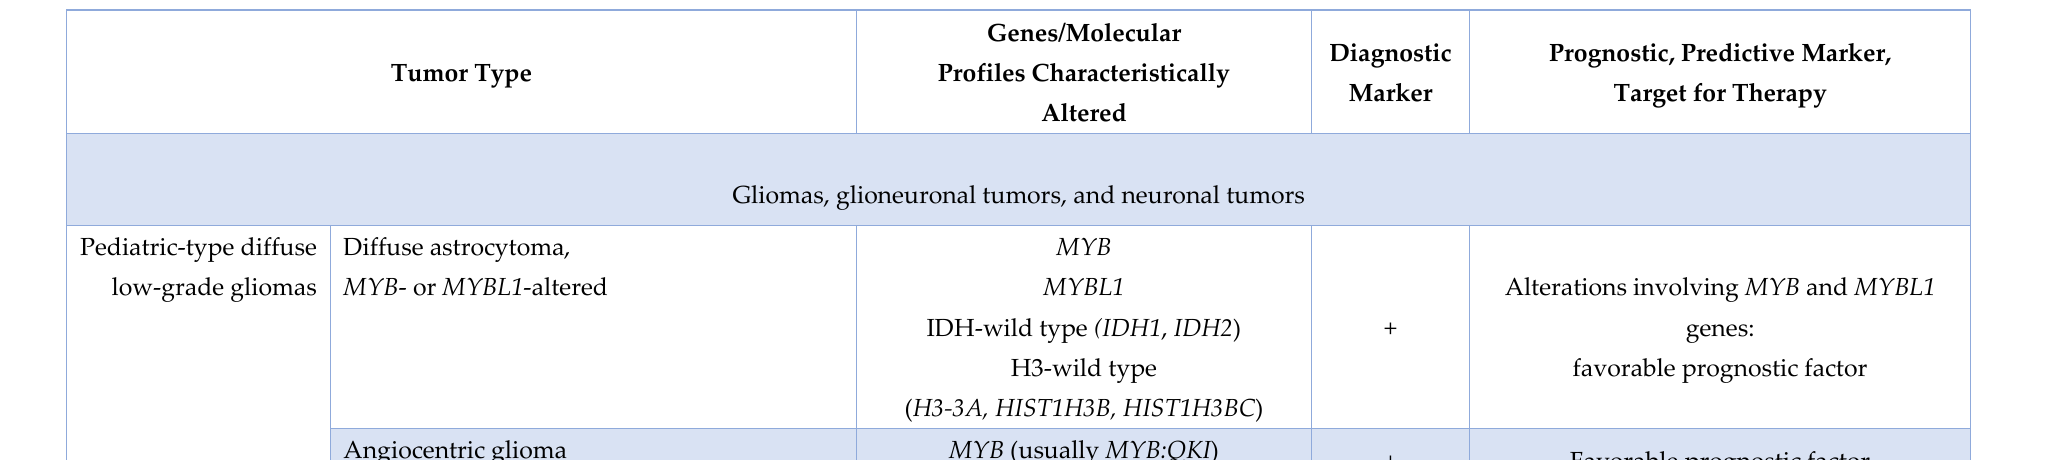
Table 1. Molecular markers—central nervous system tumors of childhood.